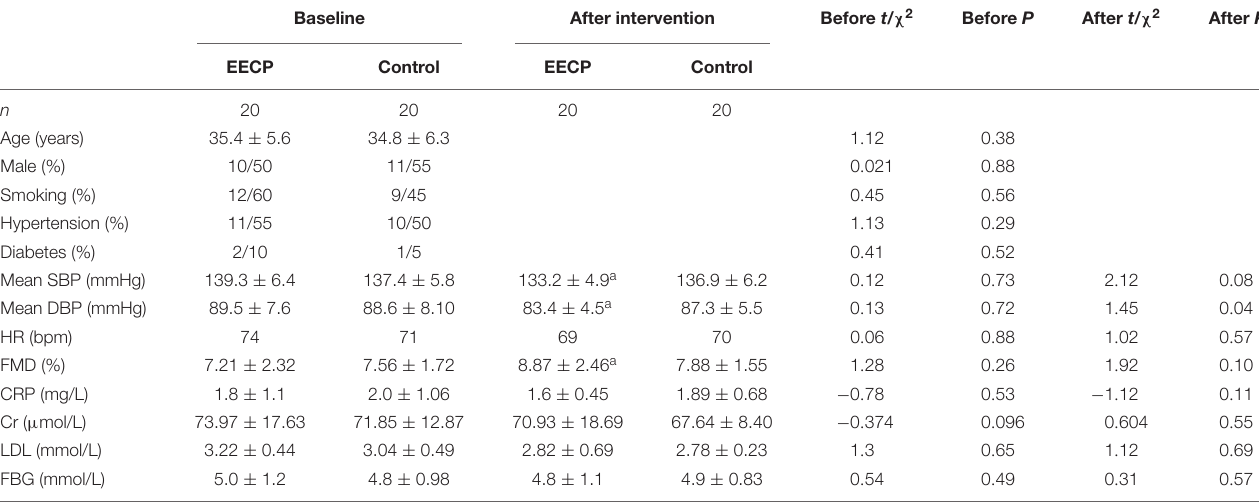
TABLE 1 | Demographic characteristics of both groups at baseline and end of intervention. Baseline After intervention Before t / χ 2 Before P